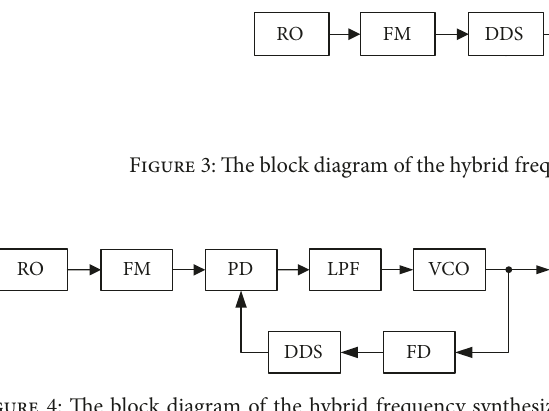
Figure 4: The block diagram of the hybrid frequency synthesizer with DDS as a frequency divider in the feedback loop of the PLL.